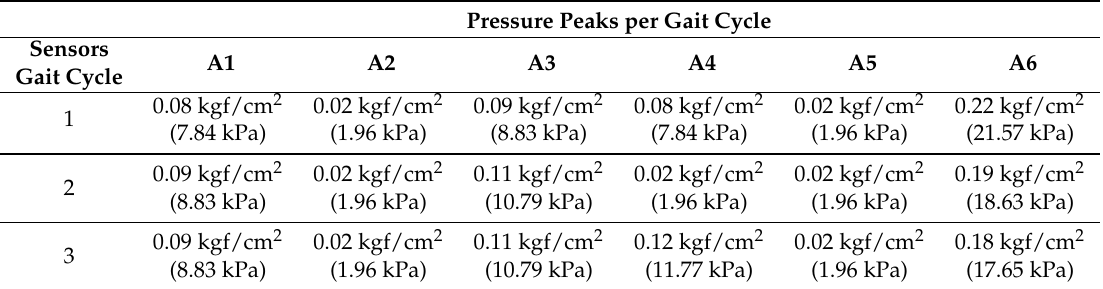
Table 2. Peak pressures recorded by the sensors in each cycle of the gait for